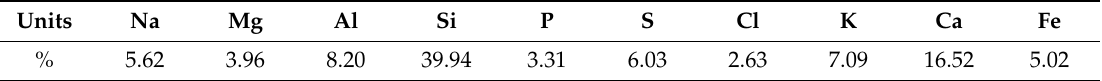
Table 2. Main Oxides Composition from Energy Dispersive X-Ray Analysis (EDXA) of WCSA. Units